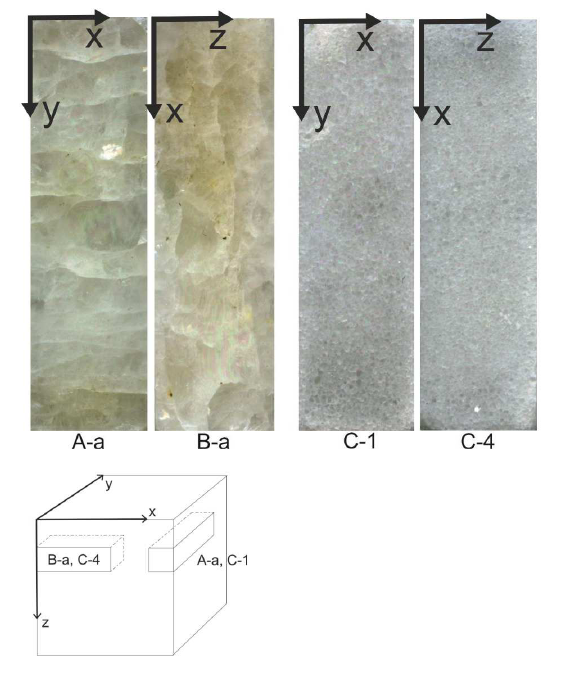
Figure 2. Orientation of cuboid specimens, A-a and B-a is Sneznikovsky marble and C-1 and C-4 is Carrara